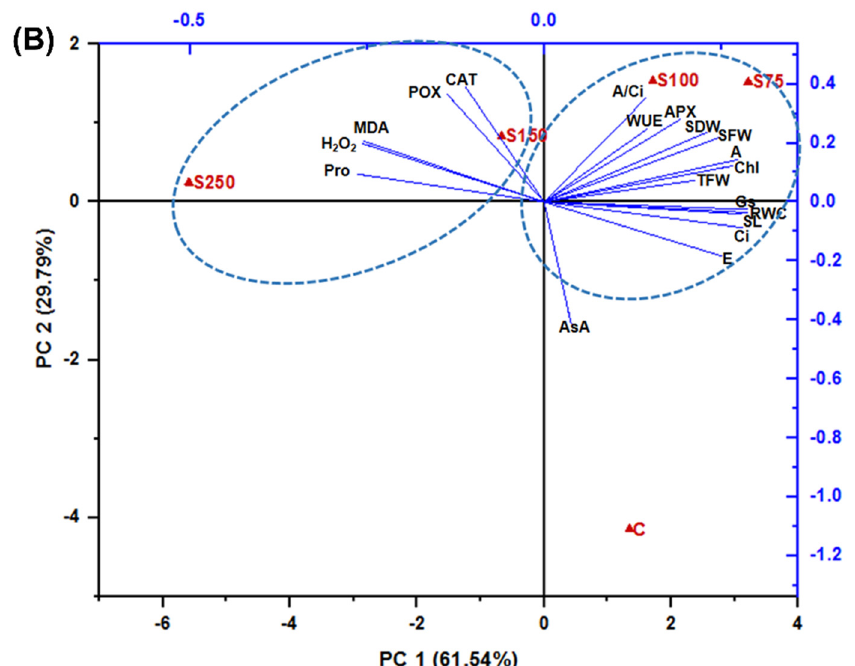
Figure 5. Hierarchical clustering and heatmap analysis ( A ), and principal component analysis (PCA) ( B ) to reveal the treatment-variable associations of sugar beet grown under different salt concentrations for a period of 95 days. At the variable level, two separate clusters (A and B) were recognized. In the heatmap, the color scale shows the intensity of the standardized mean values of different parameters. In PCA, the lines starting from the central point of the biplots display negative or positive associations of different variables, and their proximity specifies the degree of correlation with a specific treatment. Control (C), 0 mM NaCl; S75, 75 mM NaCl; S100, 100 mM NaCl; S150, 150 mM NaCl; S250, 250 mM NaCl. SL, shoot length; SFW, shoot fresh weight; SDW, shoot dry weight; TFW, tuber fresh weight; RWC, relative water content; Pro, proline content; Chl, total chlorophyll content; H 2 O 2 , hydrogen peroxide content; MDA, malondialdehyde content; CAT, catalase activity; POX, peroxidase activity; APX, ascorbate peroxidase; ASC, ascorbate content; A, net CO 2 assimilation rate; Gs, stomatal conductance; E, transpiration rate; Ci, intercellular CO 2 concentration; A/Ci, carboxylation efficiency; WUE, water use efficiency.